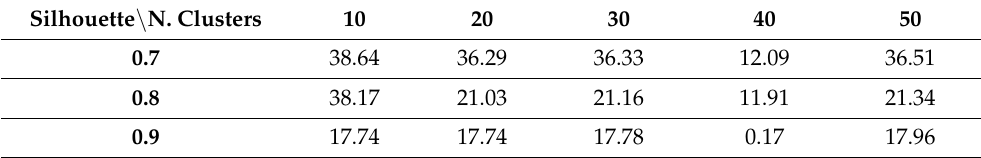
Table 19. Clustering performance in terms of silhouettes using original data. Silhouette \ N.